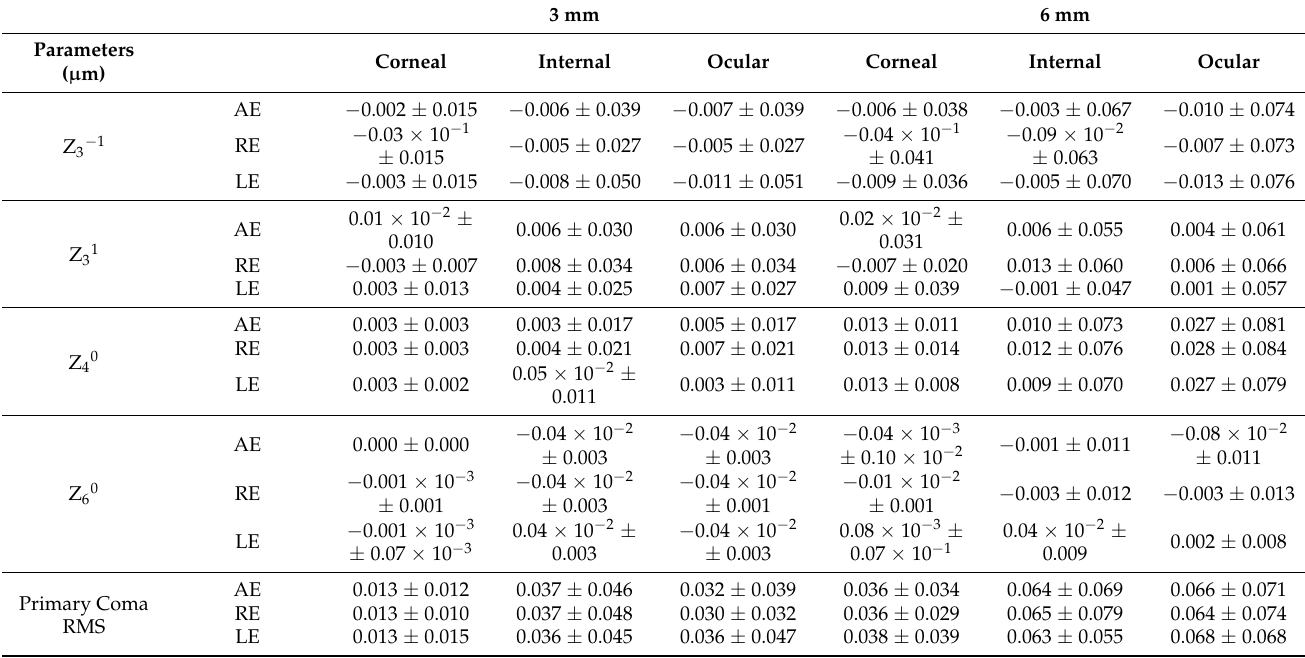
Table 2. Mean values of corneal, internal, and ocular wavefront aberrations in all, right, and left eyes for 3-mm and 6-mm pupil